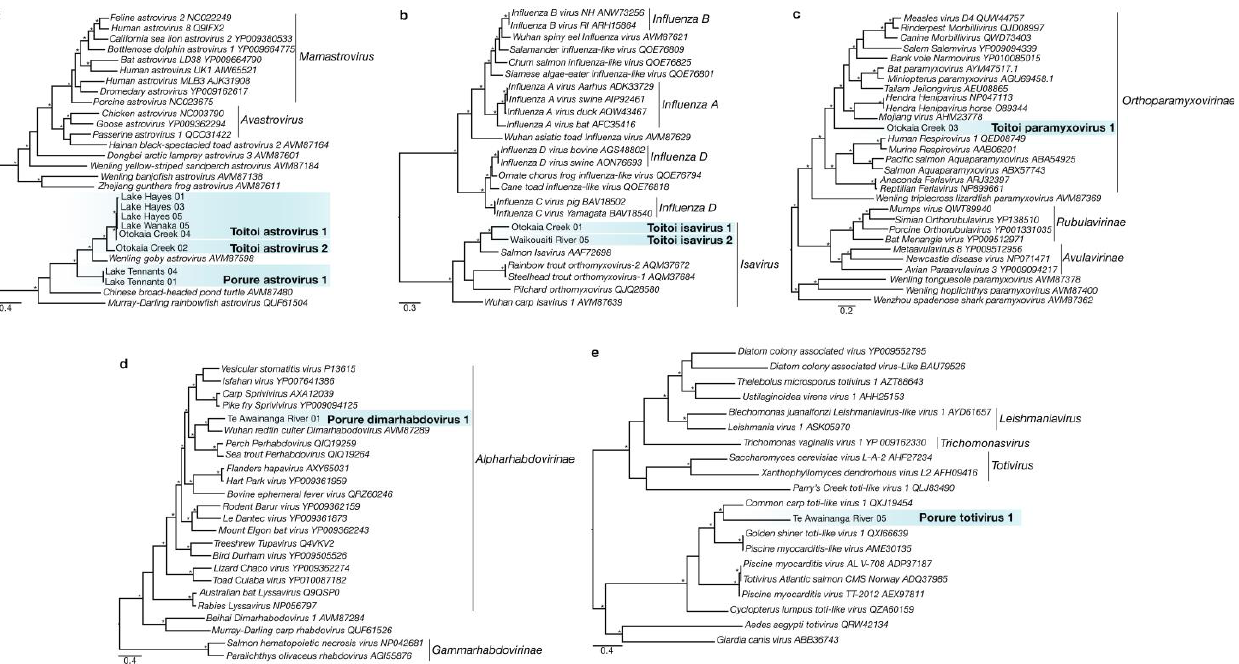
Figure 2. Maximum likelihood phylogenetic trees of the RNA-dependent RNA polymerase from representative viruses from the ( a ) Astroviridae , ( b ) Orthomyxoviridae , ( c ) Paramyxoviridae , ( d ) Rhabdoviridae, and ( e ) Totiviridae . Lineages corresponding to novel fish viruses described in this study are highlighted in blue. Phylogenetic branches with significant bootstrap values indicated with asterisks (>70). Branches are scaled to the number of amino acid substitutions per site. Amino acid length of novel RdRp sequences identified in this study used for alignment can be found in Table S1.